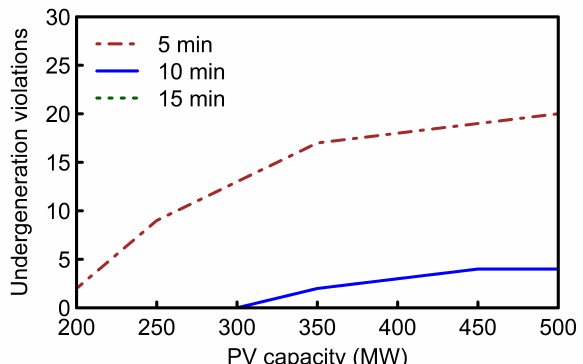
Figure 8. Under-generation violation count at increasing PV penetration rate. Under-generation occurs when PV becomes suddenly shaded and thermal units cannot ramp up fast enough to supply deficit